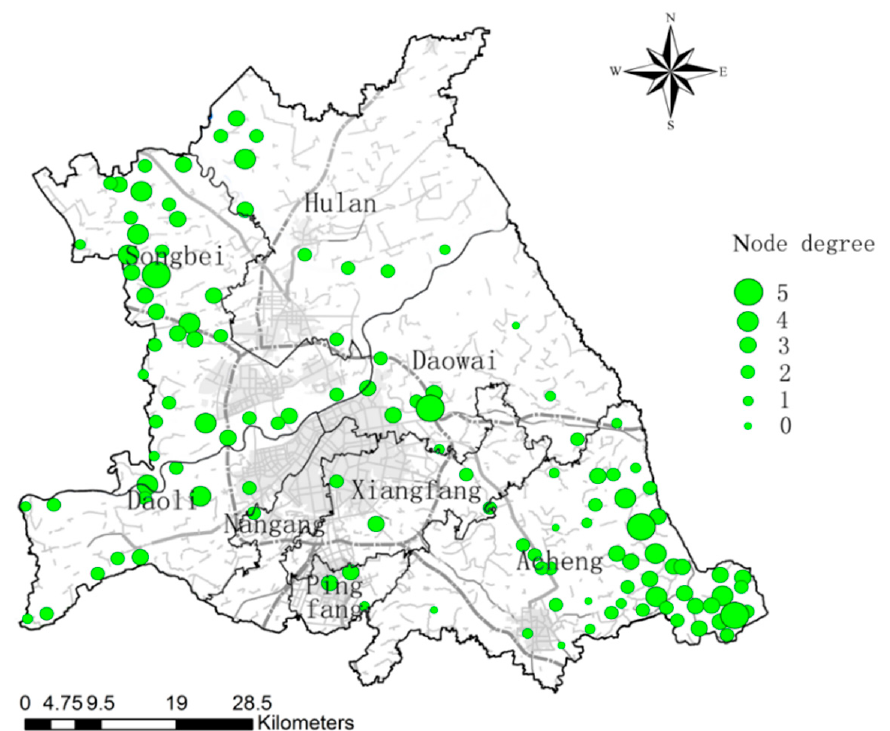
Figure 10. Ecological node degree distribution in the study area before optimization.